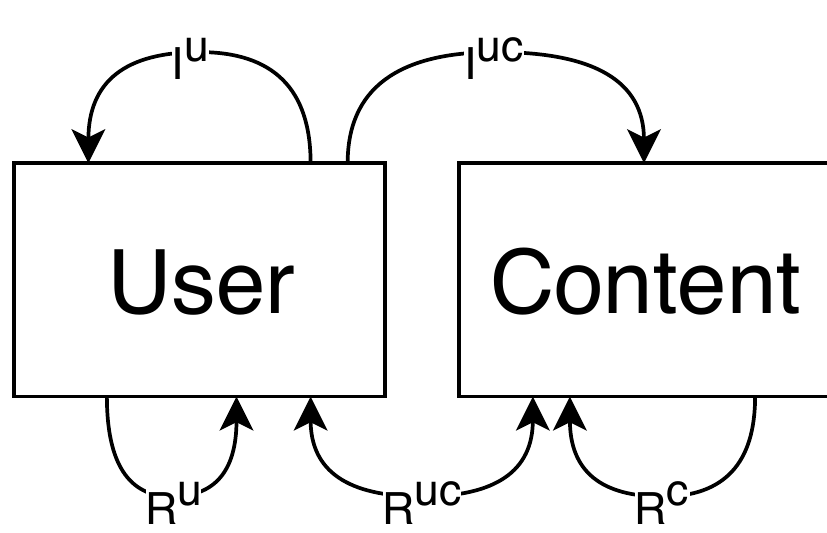
Figure 1. Model of social context, including: content ( C ), users ( U ), relations ( R c , R u , and R uc ), and Figure 1. Model of Social Context, including: content ( C ), users ( U ), relations ( R c , R u and R uc ), and interactions ( I u and I uc interactions ( I u and I uc ).